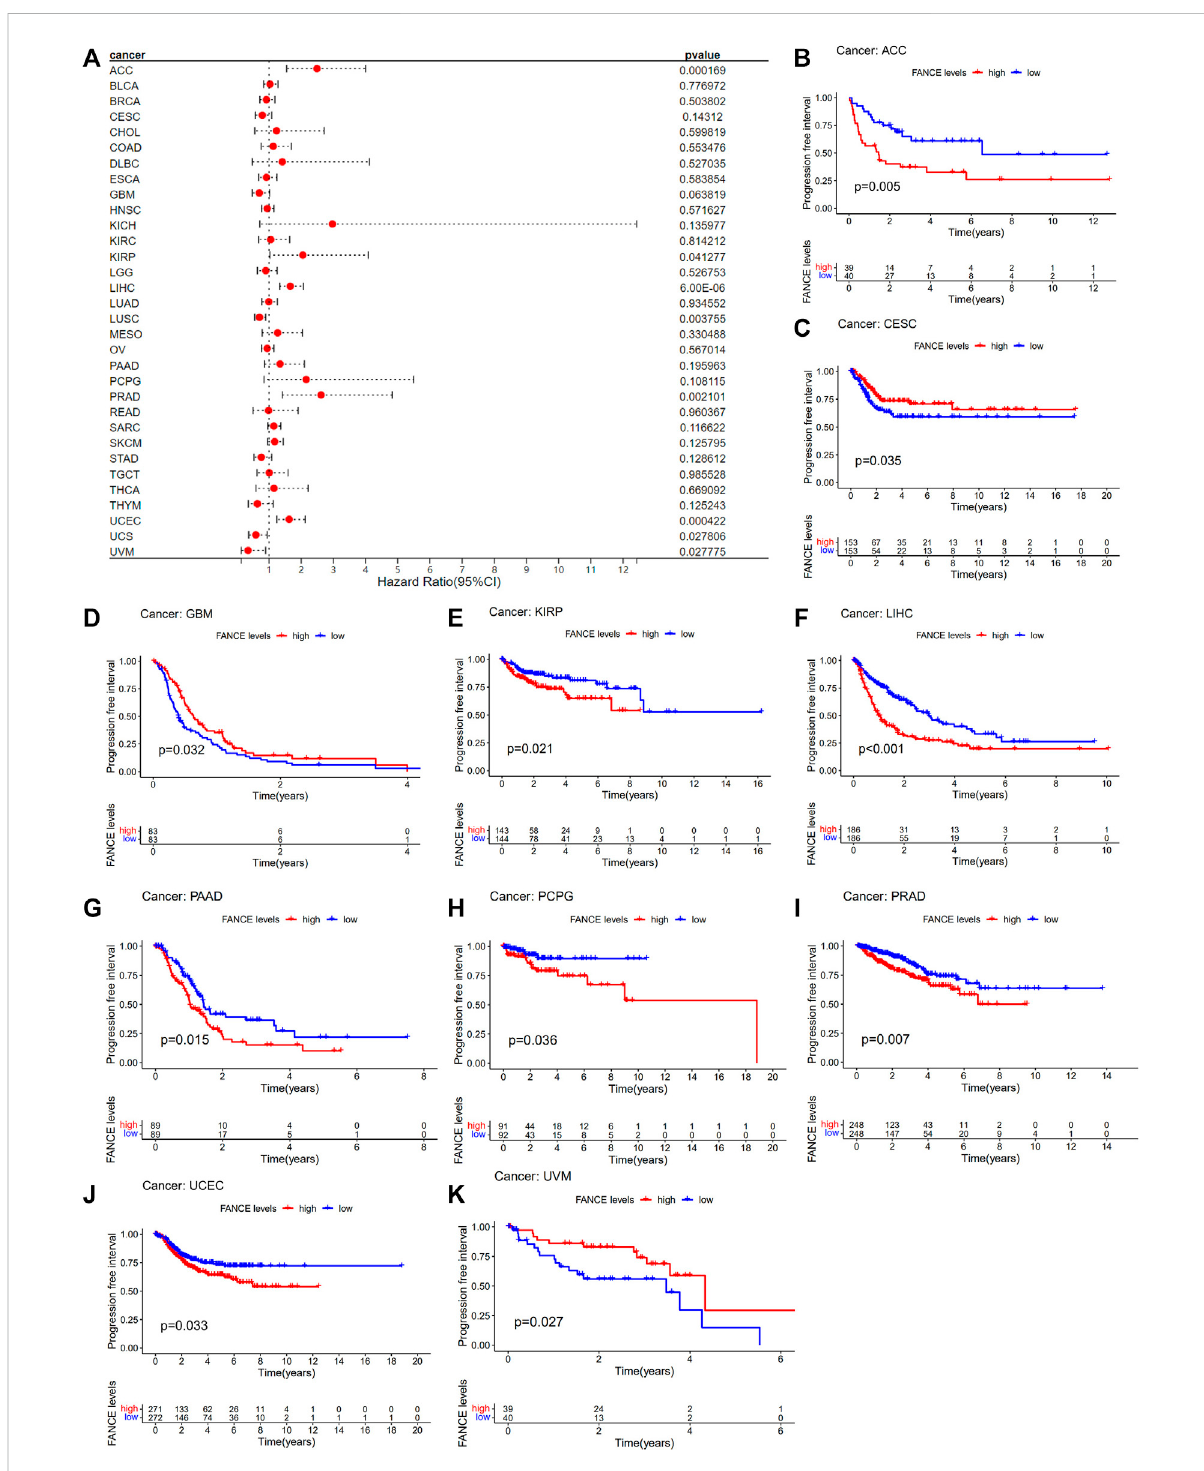
FIGURE 6 Correlation between FANCE expression and progression-free interval (PFI) using data from the TGCA database. (A) Forest plot of FANCE expression and PFI in 32 cancers. (B) The Kaplan – Meier survival analysis for FANCE expression and PFI in 10 cancers. * p < .05; ** p < .01; and *** p <